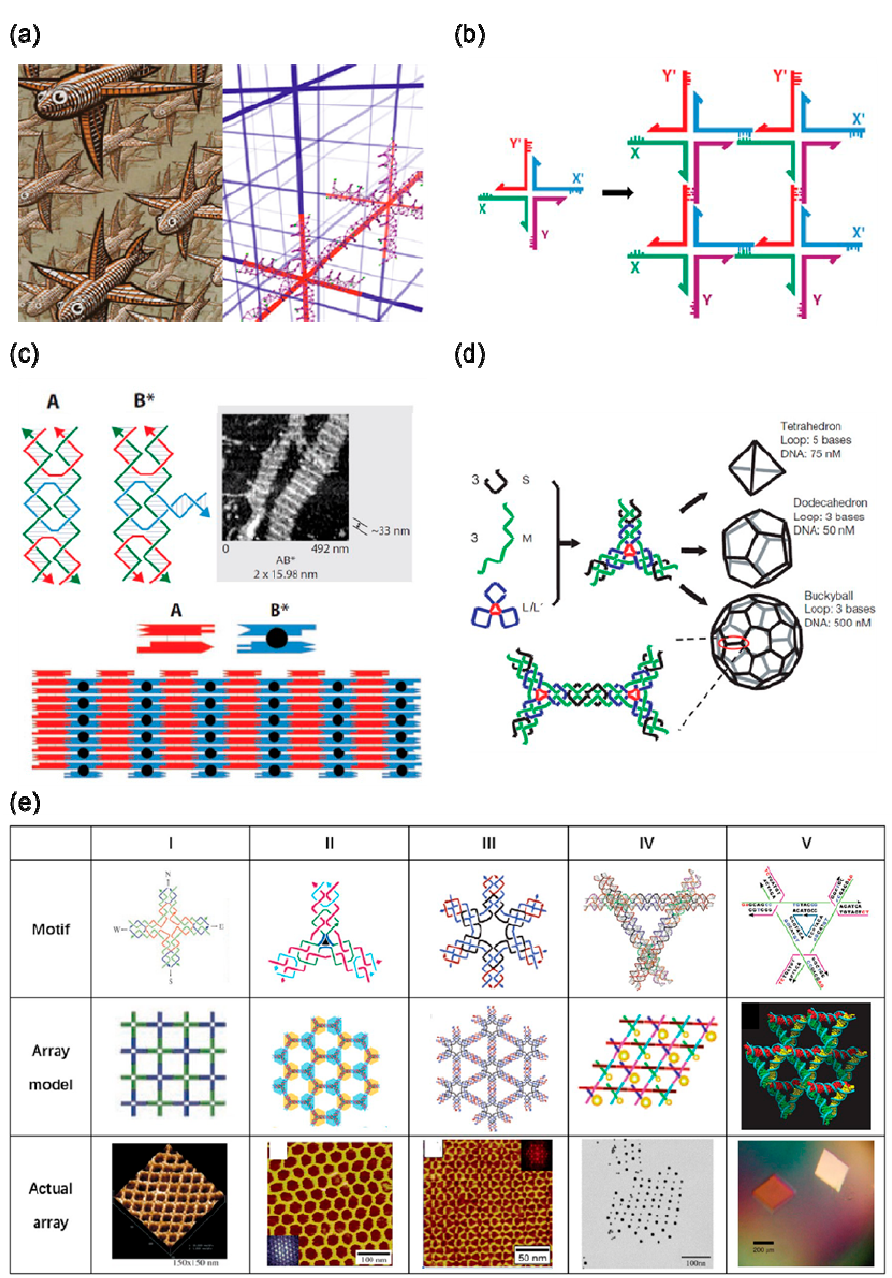
Figure 1. Self-assembly based on DNA tiles ( a ) Escher’s woodcut depth ( left ) and the prototype of DNA nanotechnology inspired by it ( right ). Reproduced from [21]. ( b ) A schematic diagram of a two-dimensional (2D) DNA lattice assembled by four-arm holiday junctions connected by sticky ends. Reproduced with permission [22]. Copyright Materials Research Society, 2017. ( c ) A 2D lattice assembled by DNA double-crossover molecule (DX) and DX + J tiles. Reproduced